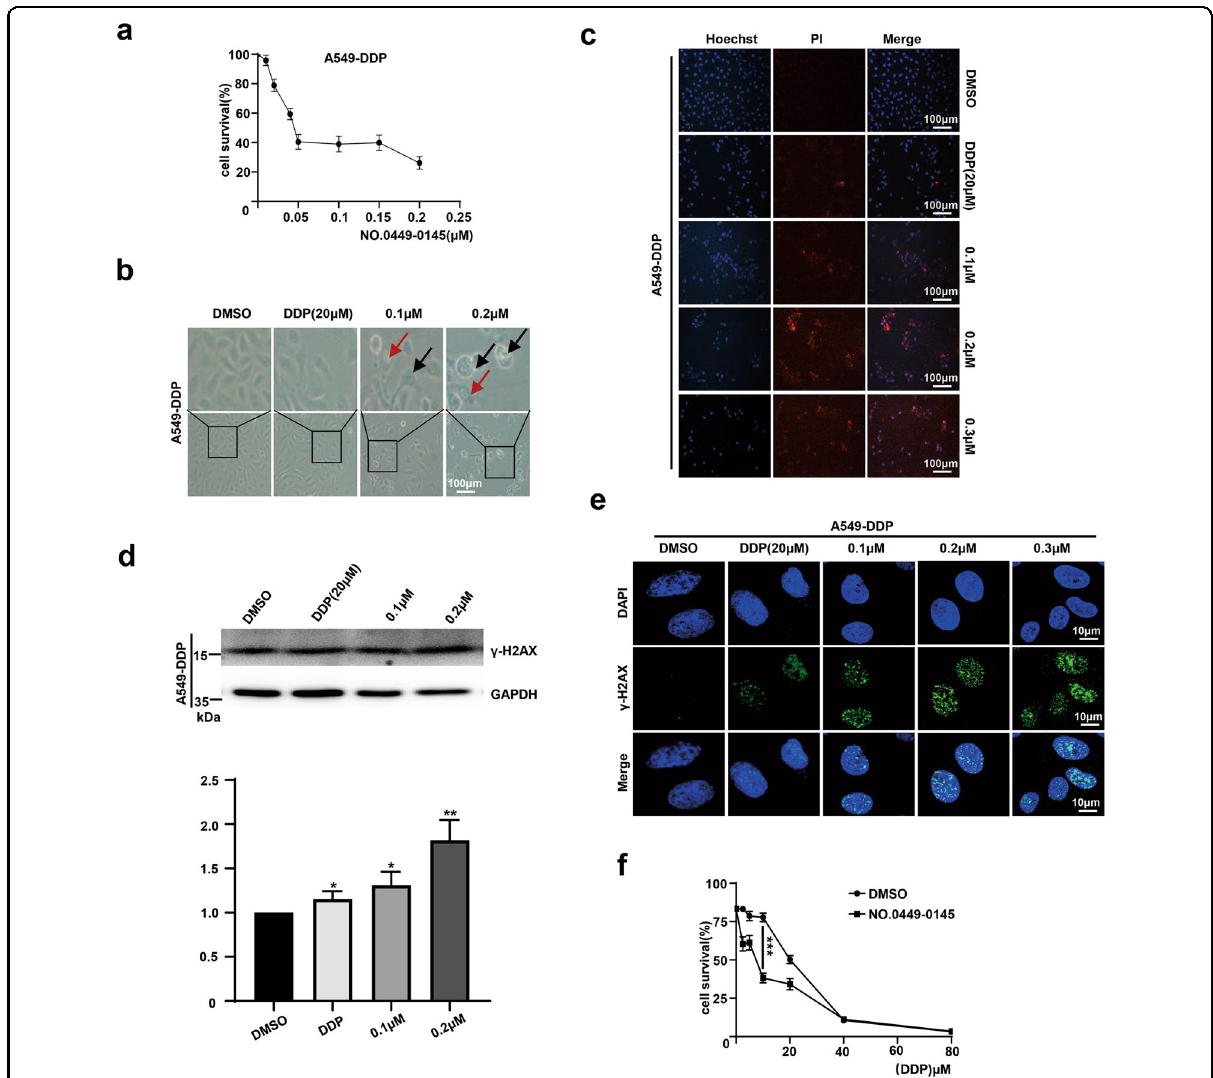
Fig. 6 NO.0449-0145 overcomes the cisplatin resistance of A549 cell. a Cell survival assay in A549-DDP cells treated with NO.0449-0145 for 48 h. b Morphological analysis of different treated A549-DDP cells. c Representative Hoechst/PI fl uorescence images of A549-DDP cells with different treatment. d Western blotting analysis of γ -H2AX in different treated A549-DDP cells. e Representative image of Immuno fl uorescence staining for γ - H2AX foci. f Drug sensitivity assay of A549-DDP cells following co-treatment with cisplatin and NO.0449-0145 or vehicle. The data are presented as the mean ± SD values, and the error bars represent data from triplicate biological experiments. * p < 0.05; ** p < 0.01; *** p <